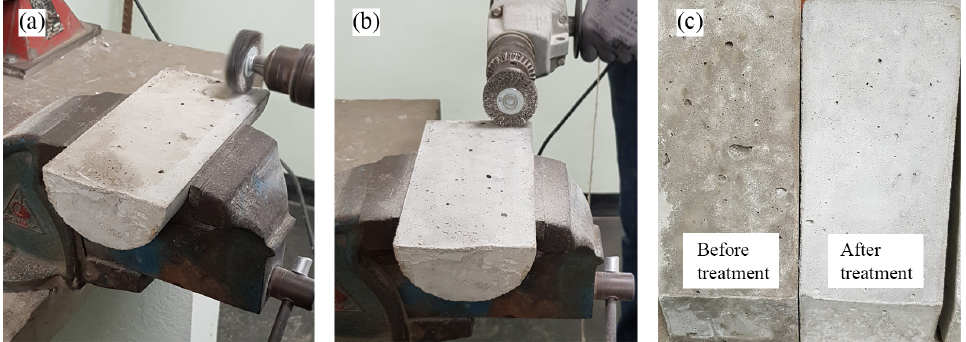
Figure 2. Surface treatment of composite models: ( a ) wire brushing in the vertical position; ( b ) wire brushing in the horizontal direction; ( c ) comparison of